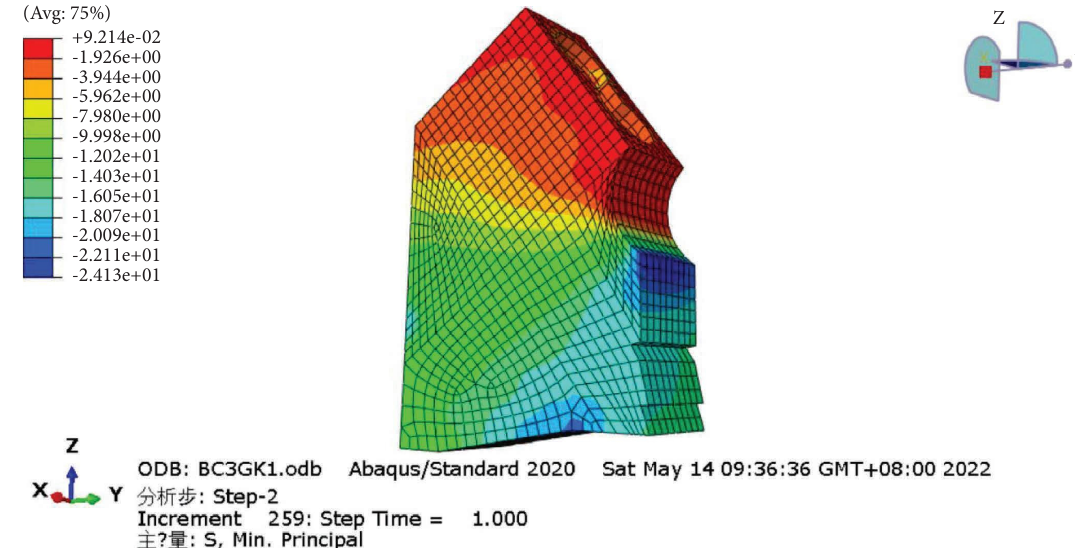
Figure 7: Cloud chart of the principal compressive stress of arch foot without anchorage of condition 10.